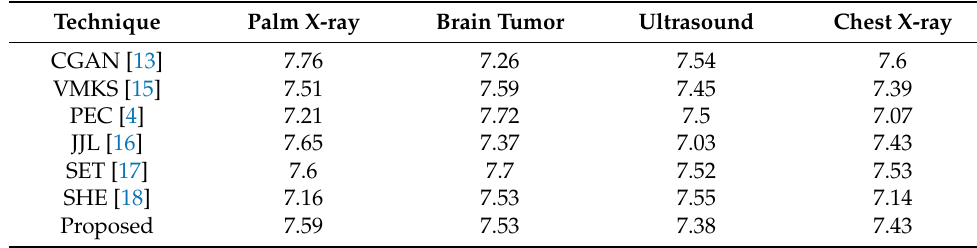
Table 3. Performance evaluation of color images in terms of